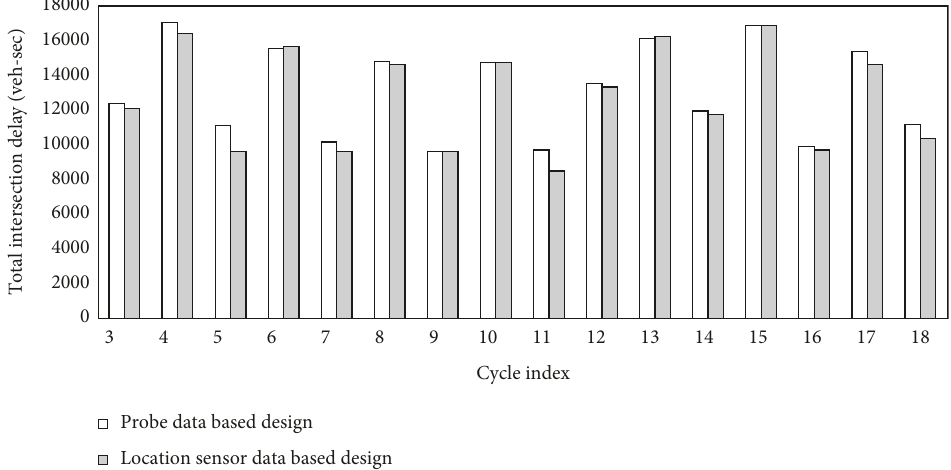
Figure 10: Comparison of total intersection delay computed theoretically by adopting Model I and